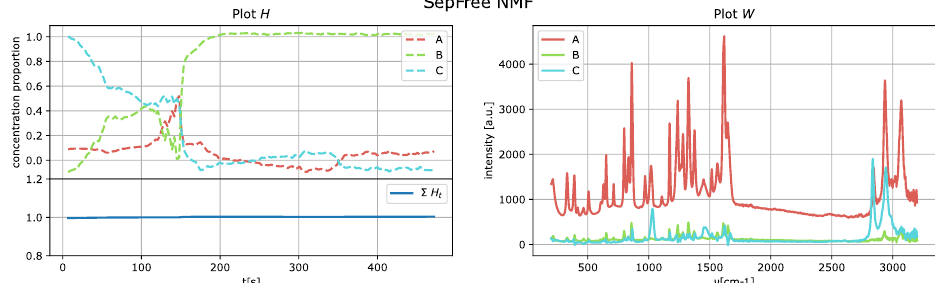
Figure 8. SepFree NMF analysis of the crystallization Raman spectrum with r = 3. Minimal memory effect is det ( S ) = 0.106.